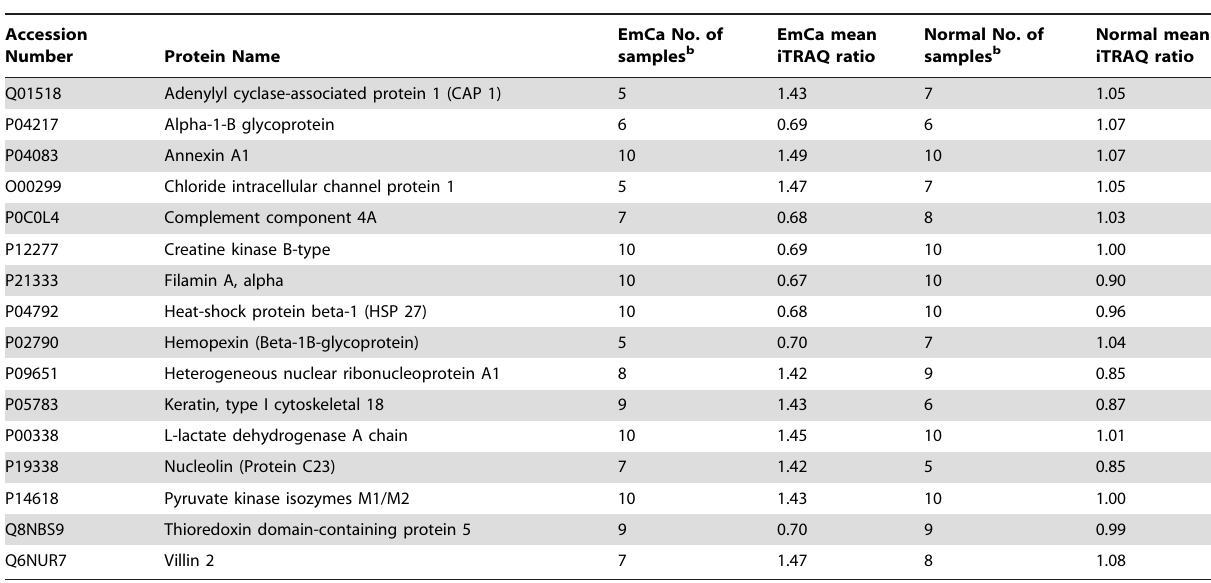
Table 3. Additional potential EmCa biomarker candidates a .